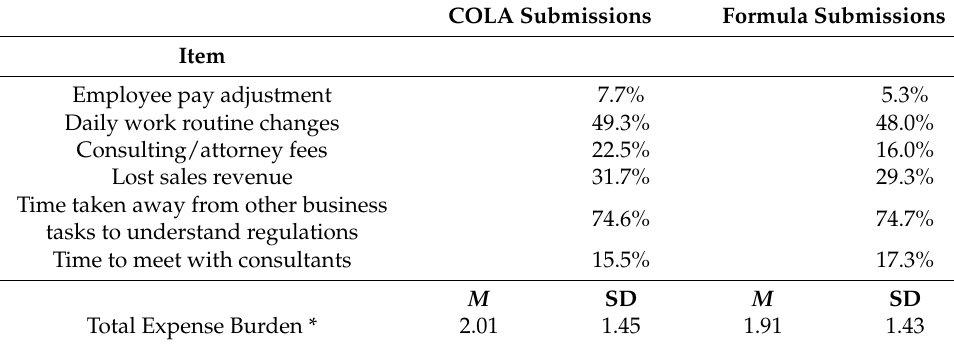
Table 10. Frequency of Brewers that Reported “Yes” to Expenses Associated with COLA and Formula Submissions.